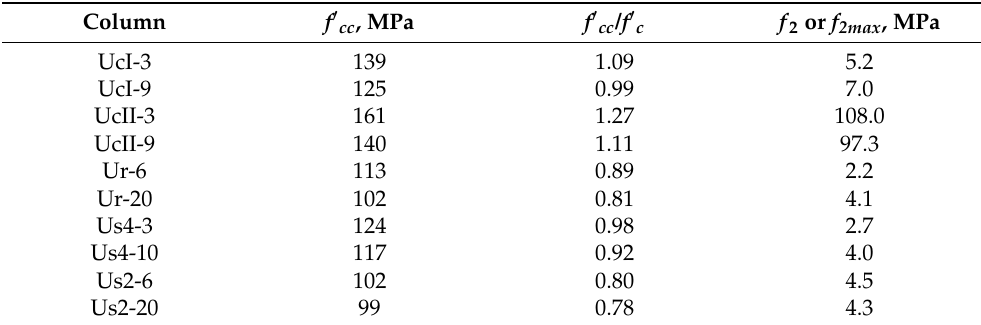
Table 4. Quantified concrete confined